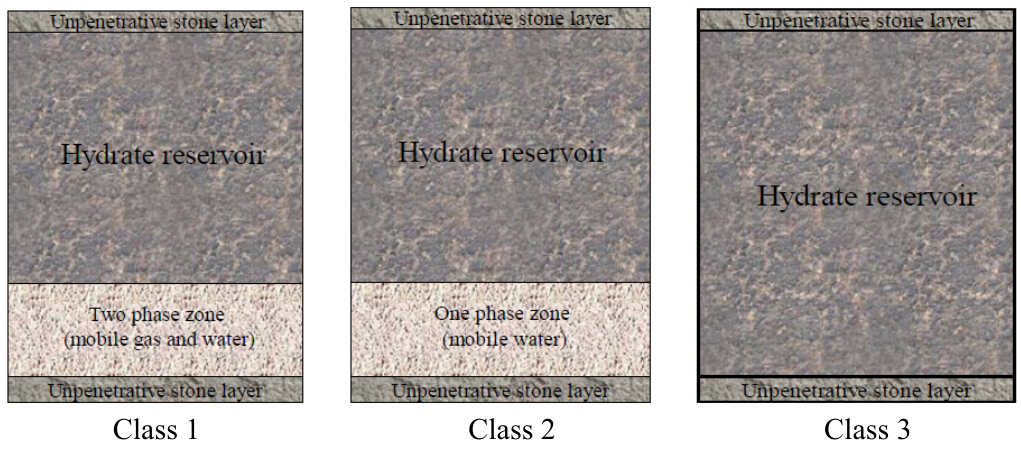
Figure 1. Sketch diagram of Classes 1, 2, and 3 hydrate